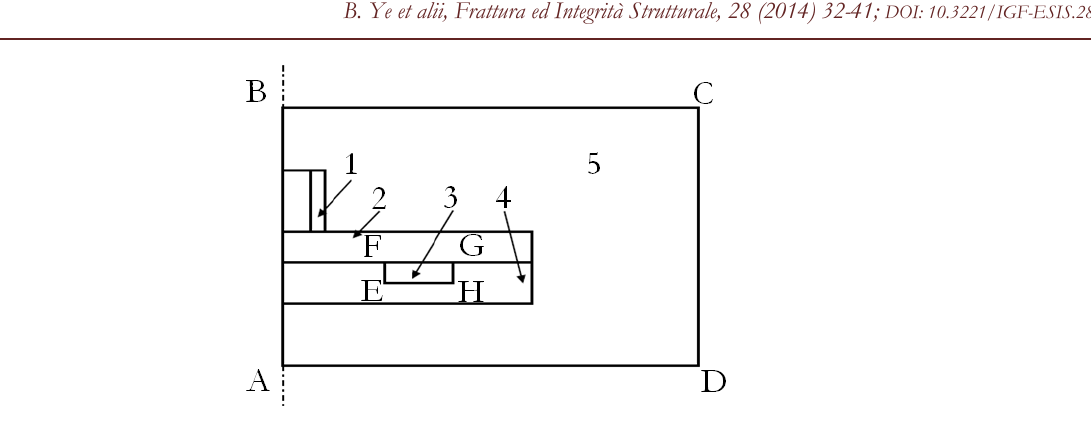
Figure 3: The solution region of FEM: 1-probe 2-aluminum plate 3-defect 4-aluminum plate 5-air region. Region boundary condition (step